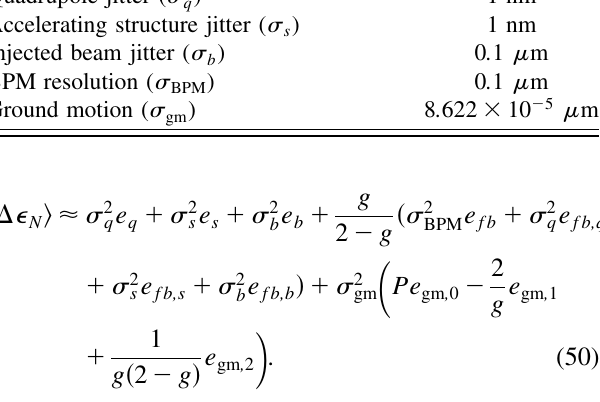
TABLE II. Magnitudes assumed for the dynamic imperfec- tions. The ground motion parameter was, as described in Sec. III C, obtained under the assumption that the ATL model parameter A (cid:2) 0 : 5 (cid:5) 10 (cid:1) 6 (cid:3) m 2 = s = m . Imperfection Magnitude ) Quadrupole jitter ( (cid:1) q